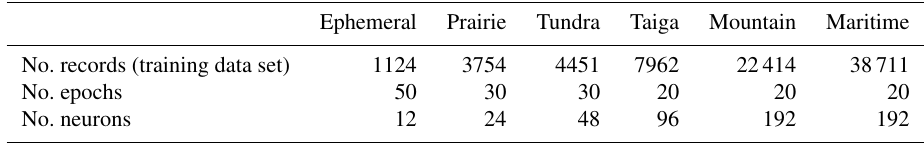
Table 5. Optimal combination of the number of hidden neurons and number of epochs for each snow class within the multiple ensemble model. Optimal combination is determined analogous to the single ensemble model in Fig. 8.